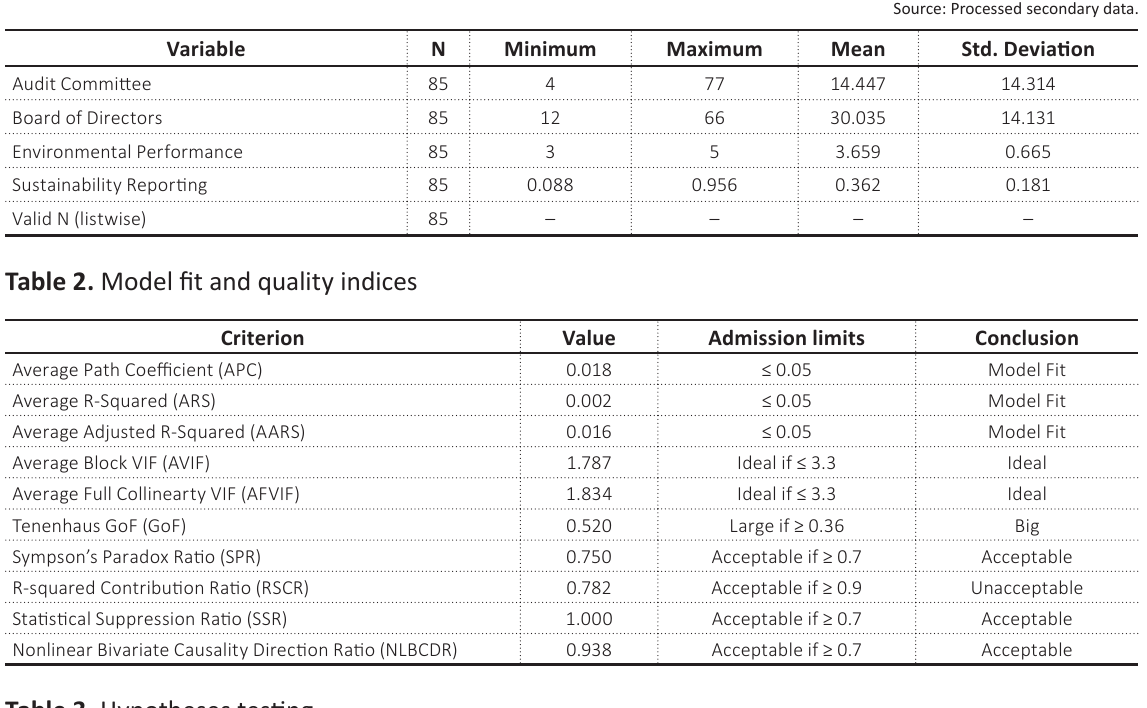
Table 1. Descriptive statistical analysis